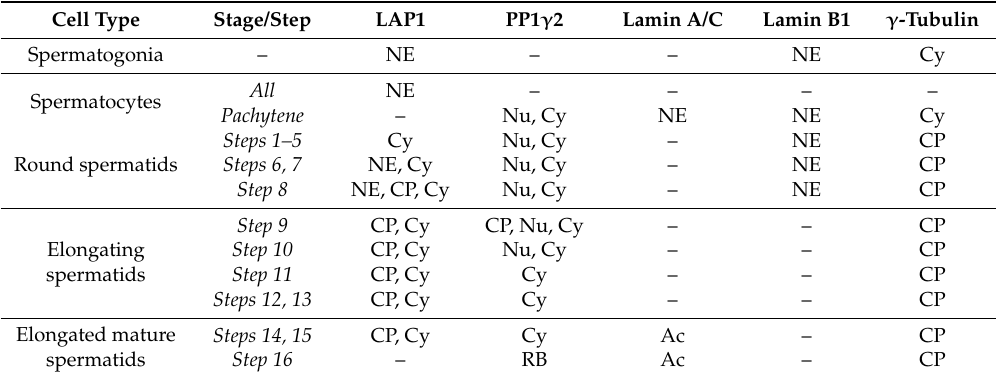
Table 1. Cellular and subcellular localization of LAP1 and its interactors during the cycle of spermatogenesis in mouse testis.